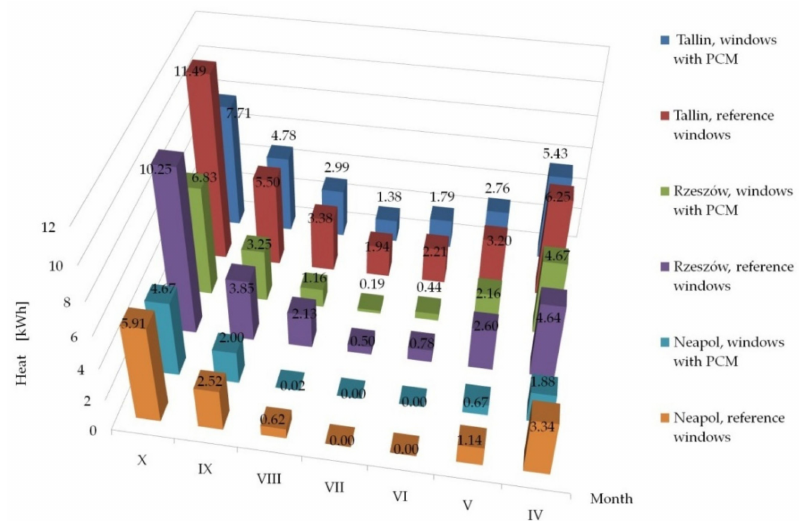
Figure 13. Summary of monthly heat losses (the absolute value) through windows with a PCM accumulator and reference windows in Tallinn, Rzesz ó w and Naples.